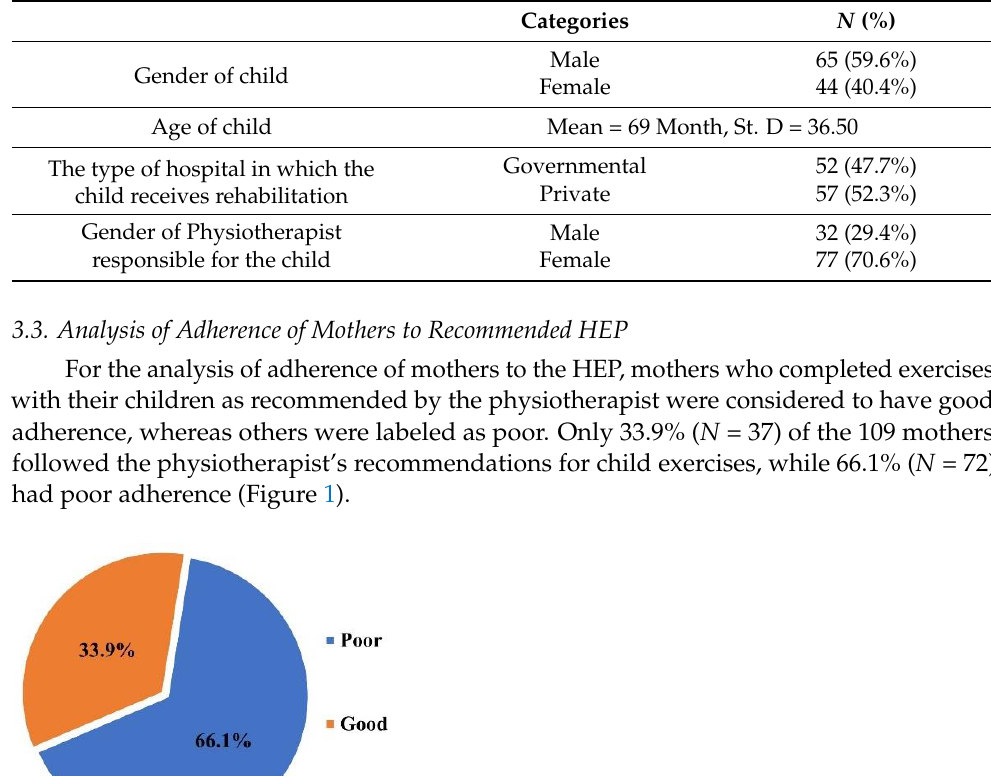
Table 2. Demographic Data of Children ( N = 109).